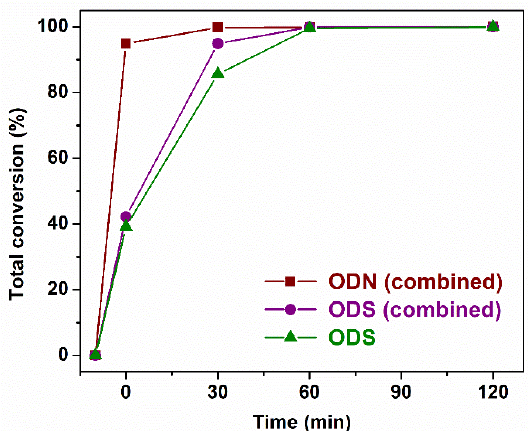
Figure 3. Denitrogenation and desulfurization profiles of a combined ODS/ODN process and also a desulfurization of a single ODS process (using a single Model Diesel containing BT, DMDBT, MDBT, and DBT), using [Na]PMo 12 catalyst, [BMIM]PF 6 extraction solvent, H 2 O 2 as oxidant, at 70 °C.